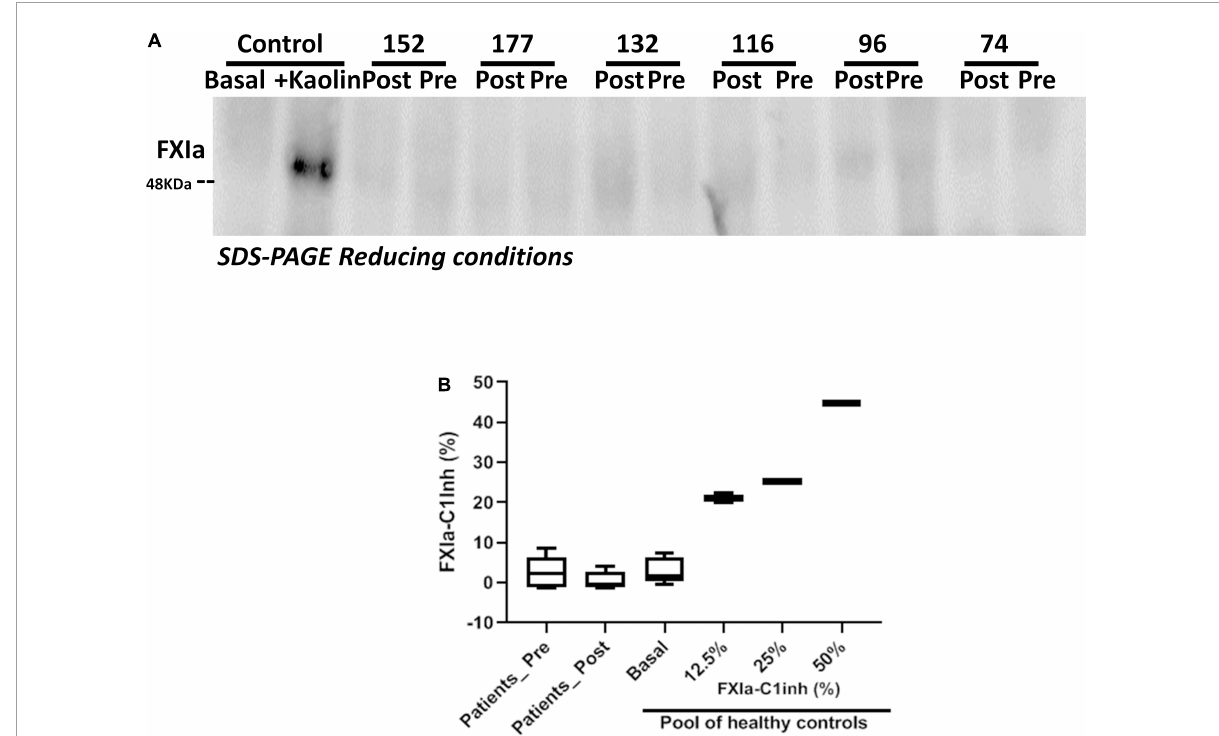
FIGURE4 FXIa levels in patient samples pre and post-procedure. (A) Representative Western blot of plasma samples of patients pre- and post- procedure. As control, plasma from a healthy subject was also evaluated without and after full activation with kaolin; (B) FXIa-C1 inhibitor complexes quantified by ELISA using nanobodies. As standards, a basal sample, and dilutions of fully kaolin-activated plasma of a pool of 100 healthy control subjects were used.